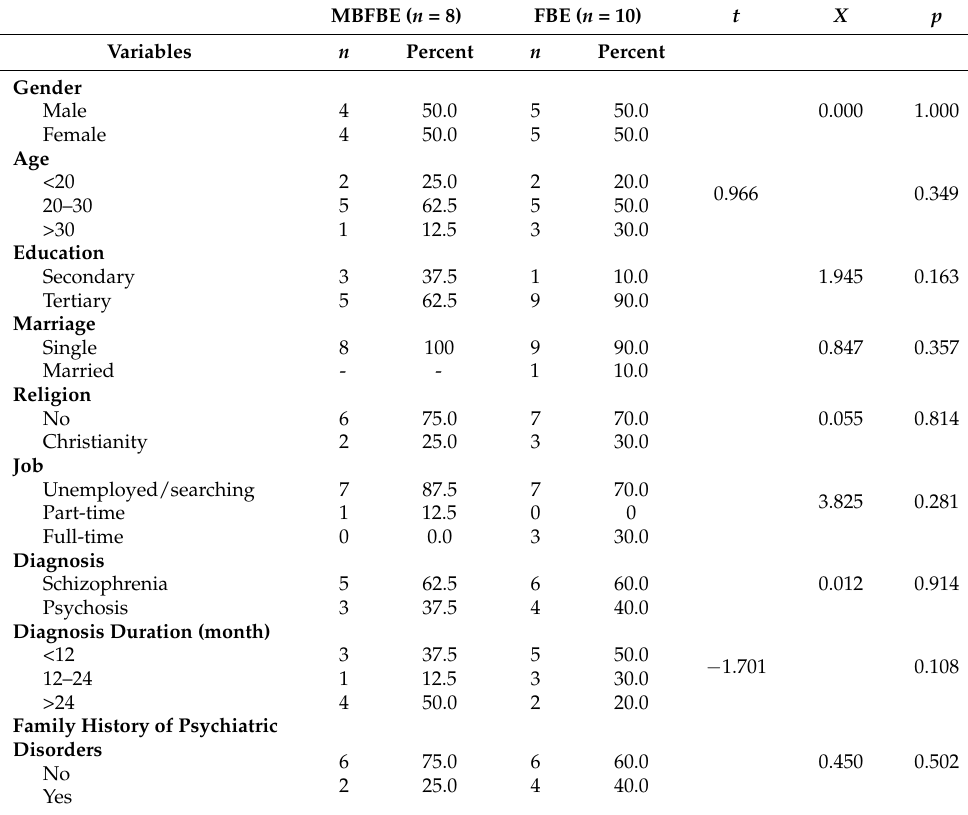
Table 2. Baseline comparison of demographic and mental-health conditions of young adults in recovery ( n =